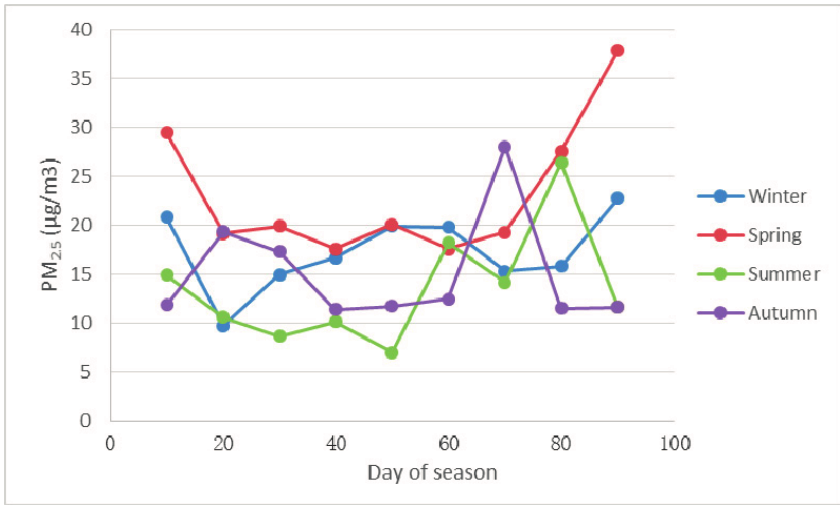
Figure 11. Seasonal PM 2.5 mass concentration variation in